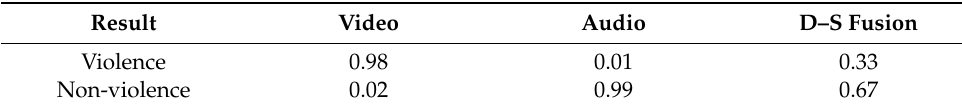
Table 4. D–S fusion result on a violent sample